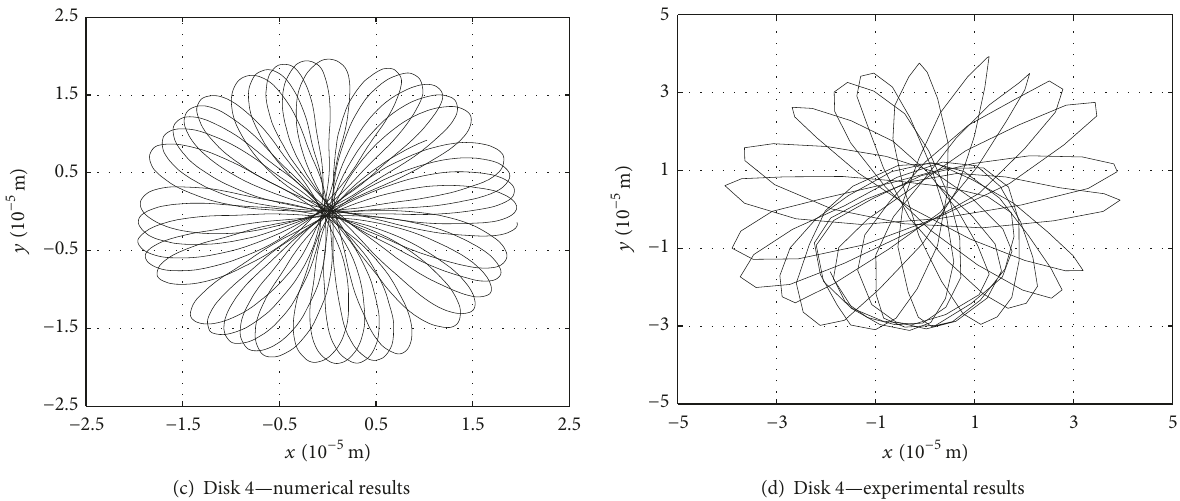
Figure 18: Orbit of disk 2 and disk 4 with 𝜔 1 = 128 rad / s and 𝜆 = −1.65